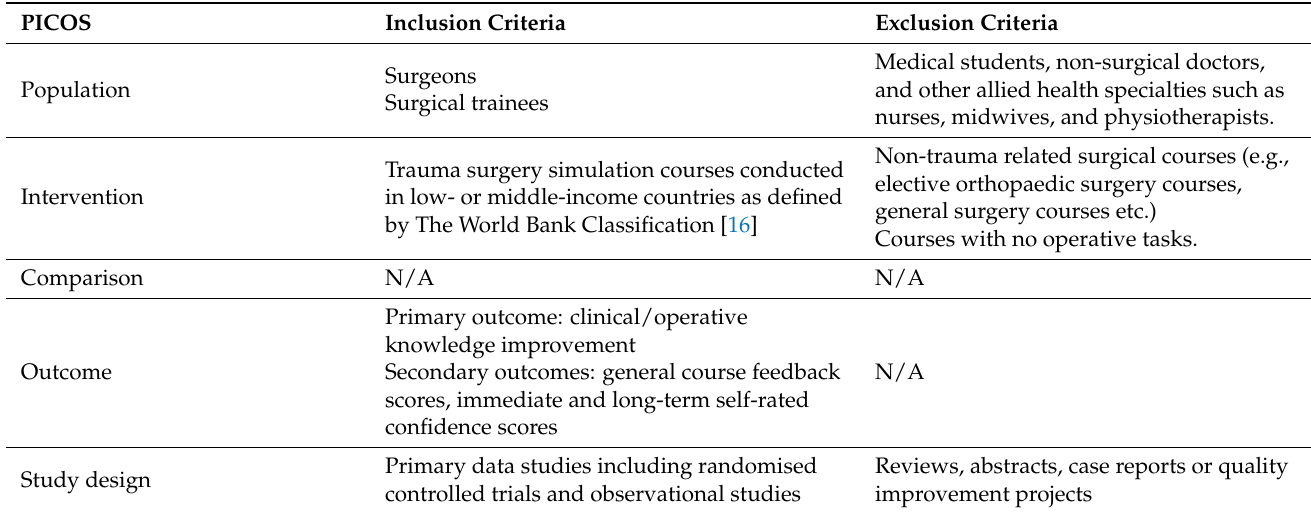
Table 1. Eligibility